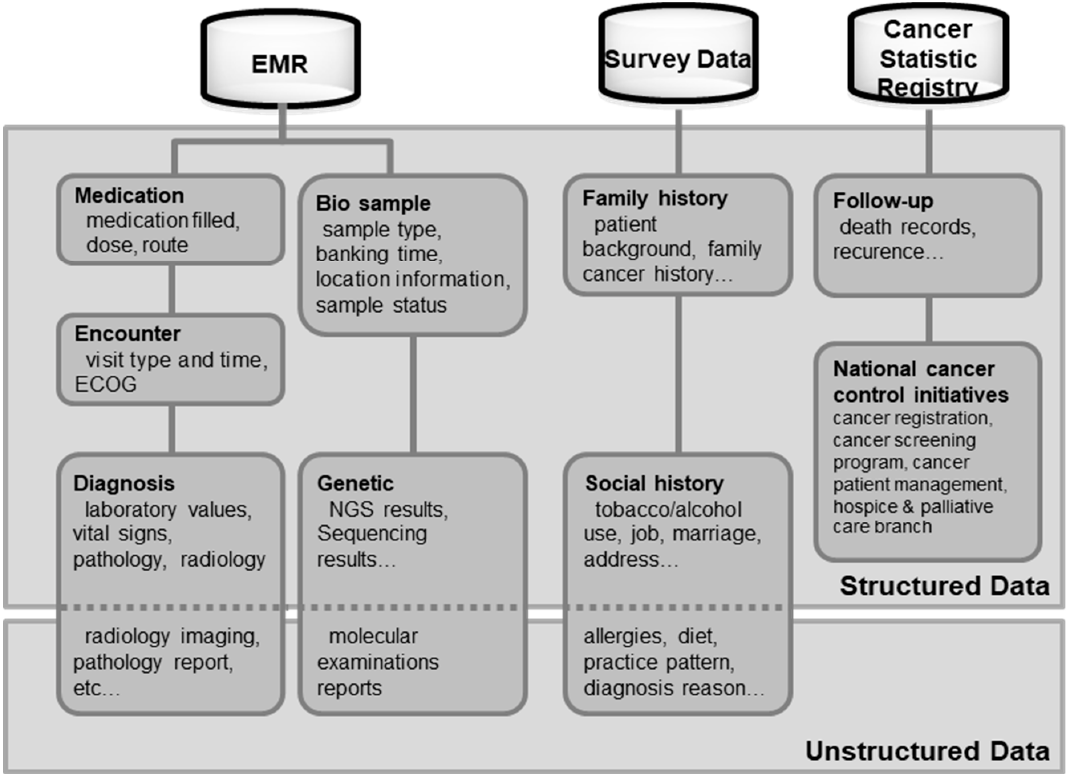
Figure 1. Overview of the integrated Korea Cancer Big Data Platform (K-CBP) by data type. ECOG, Eastern Cooperative Oncology Group performance status; EMR, electronic medical record; NGS, next-generation sequencing.